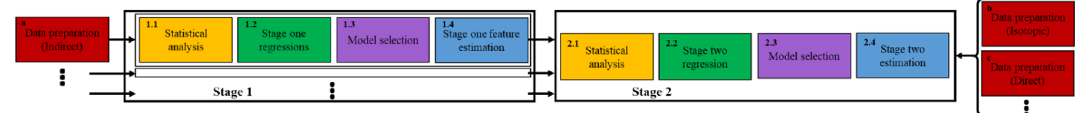
Figure 2. Scheme of the Isocompy workflow utilized to design the Isocompy architecture. It consists of data preparation (red boxes) and two main stages. Each stage includes statistical analysis (yellow boxes 1.1 and 2.1), regression (green boxes 1.2 and 2.2), model selection (violet boxes 1.3 and 2.3) and feature estimation steps (blue boxes 1.4 and